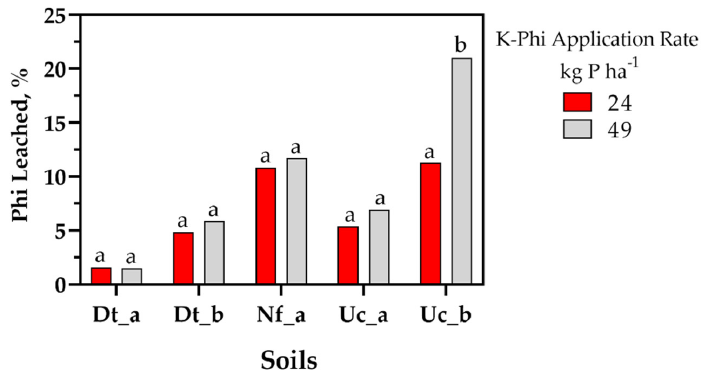
Figure 2. Percent of cumulative phosphite (Phi) leached with respect to initial Phi on a mass basis. Combined data of two leaching trials for each K-Phi application rate. For each soil, means followed by the same letter are not significantly different at a probability p < 0.01. Table 3. Water-soluble P (WSP) and Mehlich 1 P correlation to dissolved leachate P (DLP) from five soils. WSP and Mehlich 1 P are extracted mg (Phi + Pi) kg − 1 soil; DLP is the combined P (Phi + Pi) concentration of two leaching trials in mg L − 1 . WSP Mehlich 1 Soil Regression line Regression coefficient (R 2 ) Regression line Regression coefficient (R 2 released from each soil in the order of Dt_a < Dt_b < Uc_a < Nf_a < Uc _b is shown in Figure 2, but this trend was different for slopes of the regression between Mehlich 1 and DLP values.